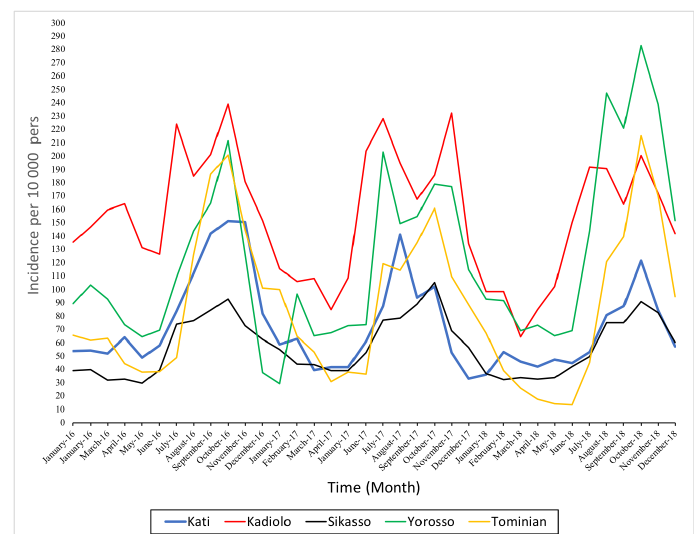
Figure 1. Monthly malaria incidence by health district from 2016 to 2018.